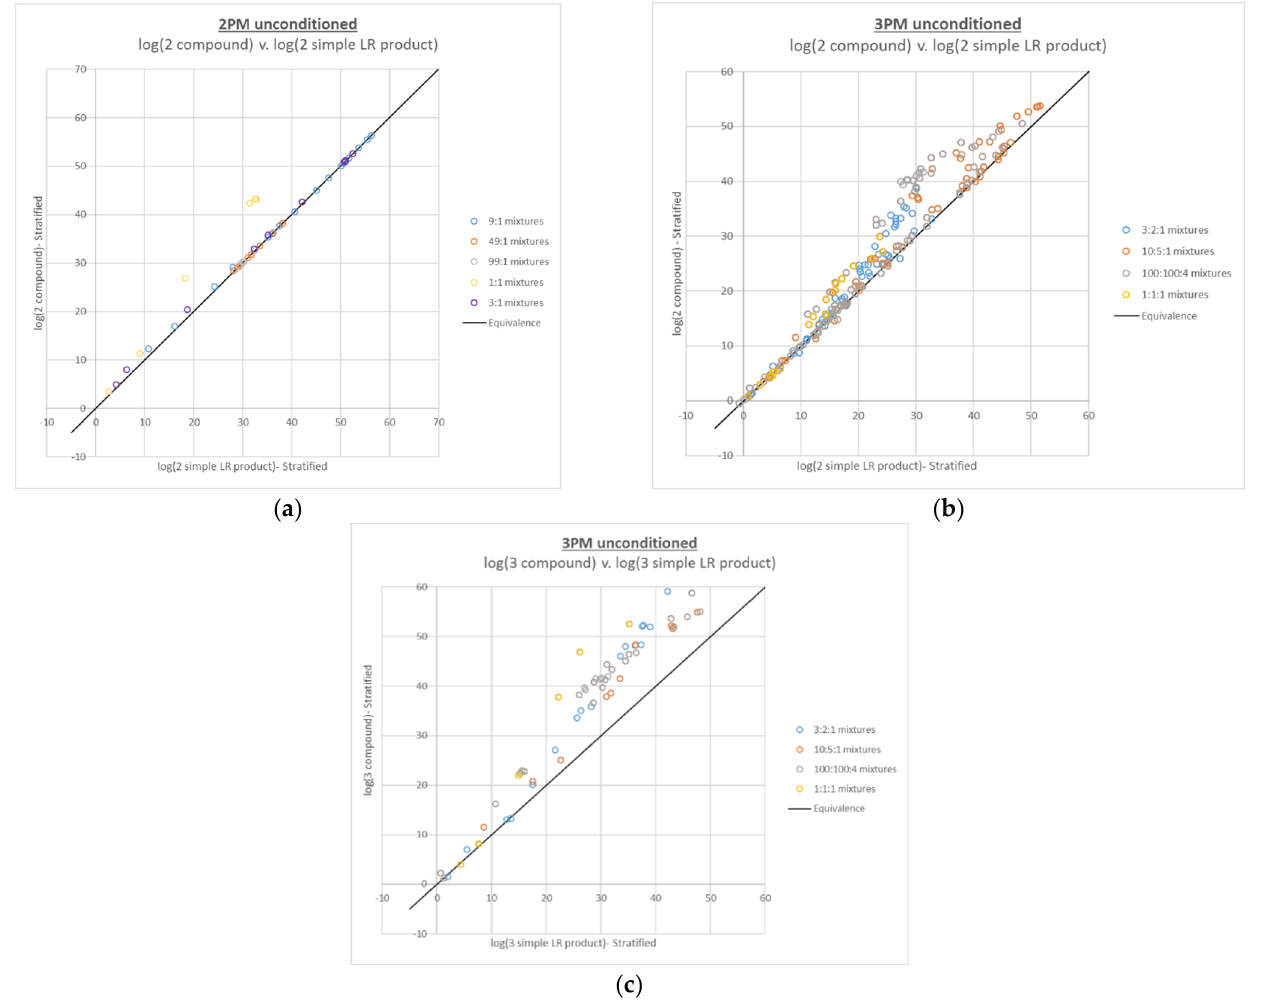
Figure 1. Plots of log(compound LR) v. corresponding log(simple LR product) for ( a ) 2-person mixtures with 2 true contributors, ( b ) 3-person mixtures with 2 true contributors, and ( c ) 3-person mixtures with 3 true contributors. mixtures with 3 true